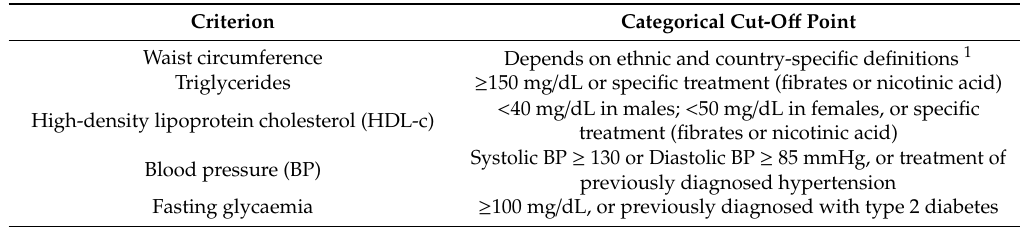
Table 1. Metabolic syndrome (MS) criteria agreed in 2009.